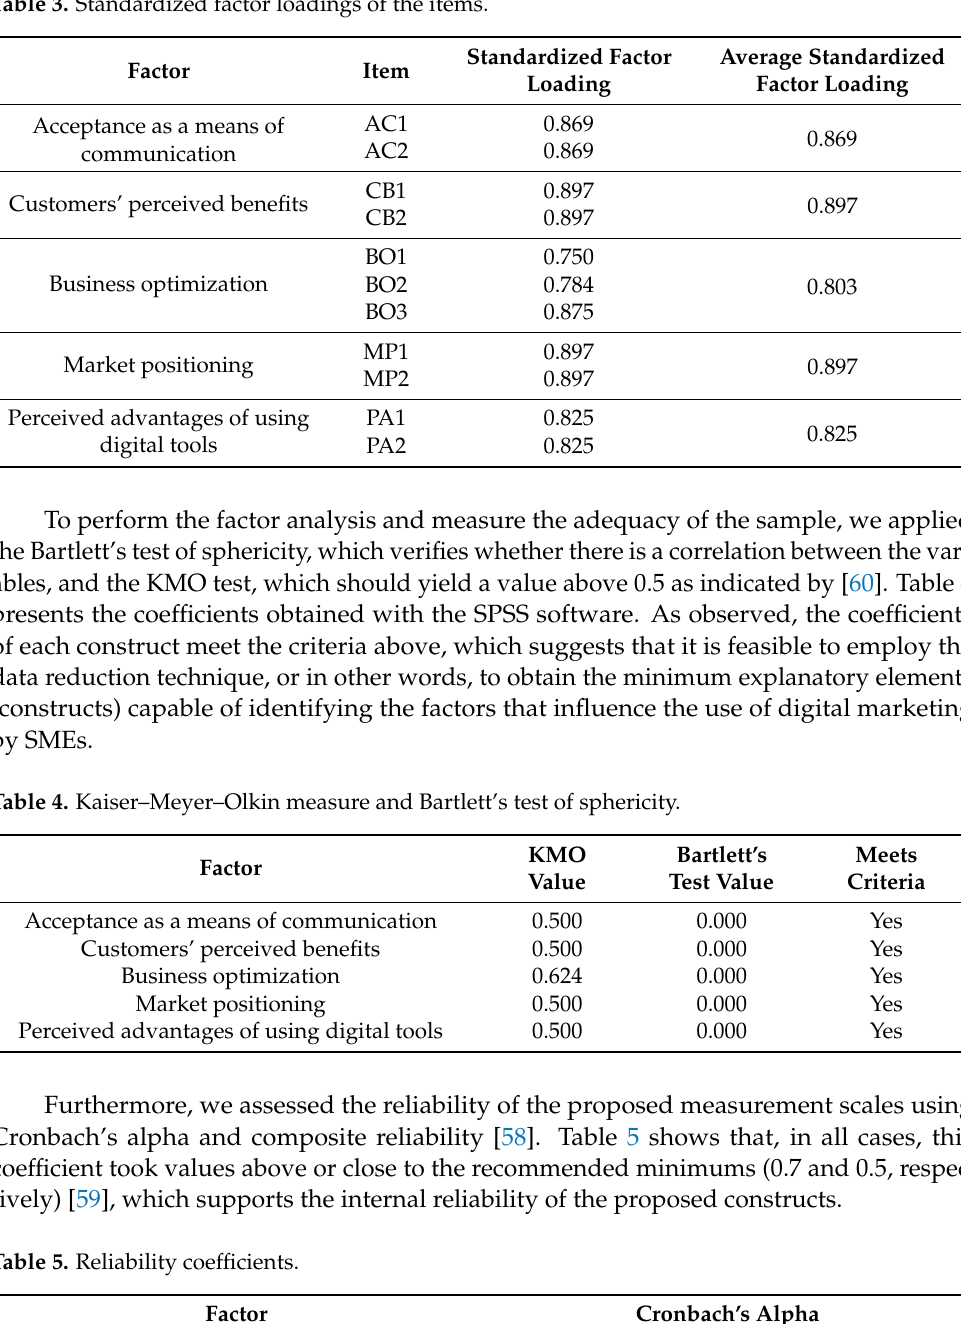
Table 3. Standardized factor loadings of the items.